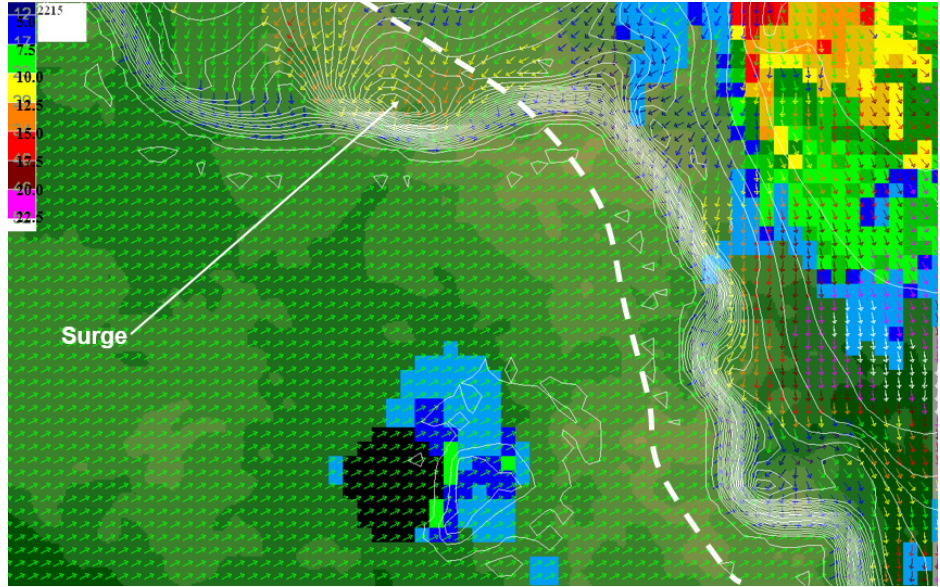
Figure 10. Same as for Figure 9 but valid for 1515 LST.